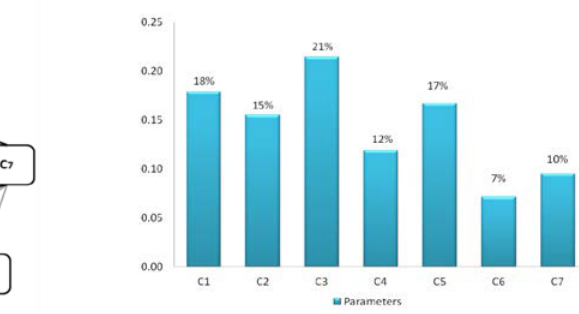
Fig. 2. The schematic hierarchy for the selection of the right Six Sigma project